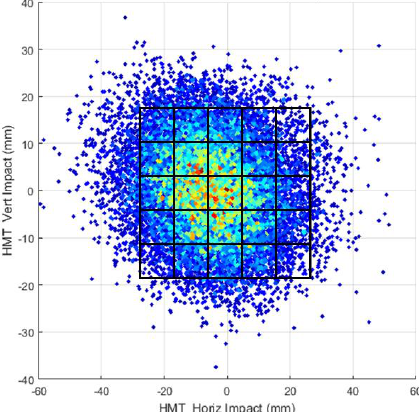
Figure 2. Example scatter plot of impact